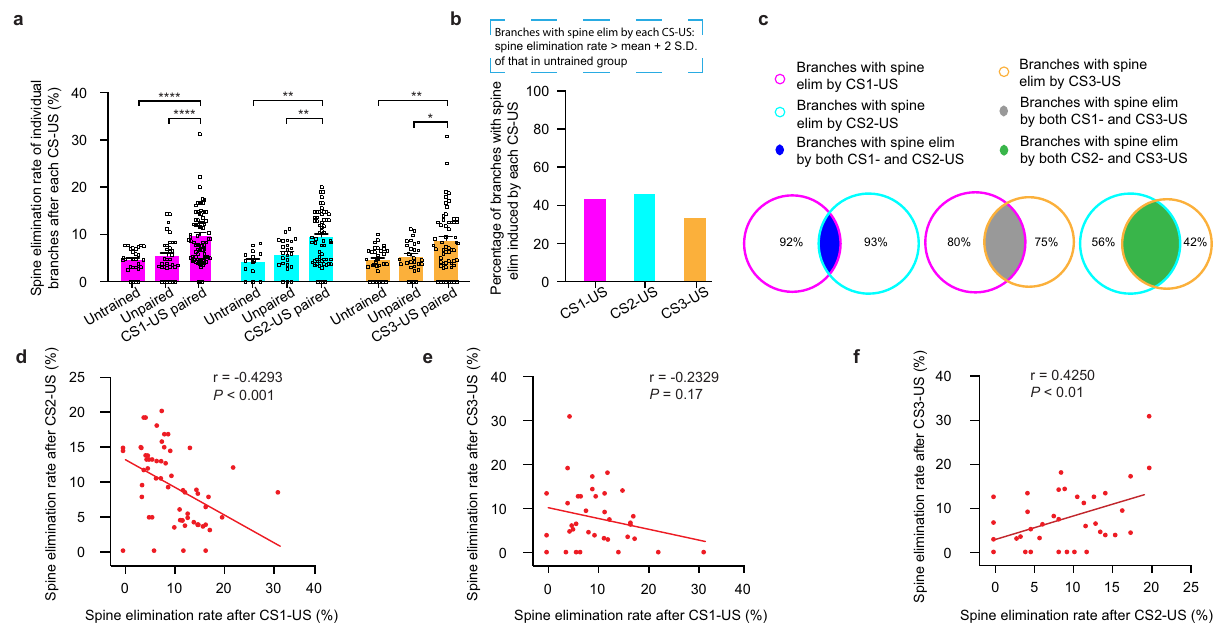
Fig.4|DistributionofspineeliminationinducedbydifferentCS-USpairingson individual dendrites. a Comparisons of spine elimination rates on individual dendriticbranchesbetweenmicesubjectedtoeachCS-USpairinganduntrainedor unpaired control mice (CS1: 1kHz; CS2: 10kHz; CS3: 5kHz; CS1-US pairing vs. untrainedorunpaired, P <0.0001; n =78,28,and34branches,respectively.CS2-US pairing vs. untrained or unpaired, P =0.0014 or P =0.0075; n =60, 14, and 24 branches respectively. CS3-US pairing vs. untrained or unpaired, P =0.0024 and P =0.0233,respectively; n =58,32,and28branches,respectively;Mann – Whitney U test). b After each CS-US pairing, ~40% of individual dendritic branches showed spine elimination rate higher than the mean plus two times the standard deviation of that in untrained control mice. c Percentage of overlap between branches with